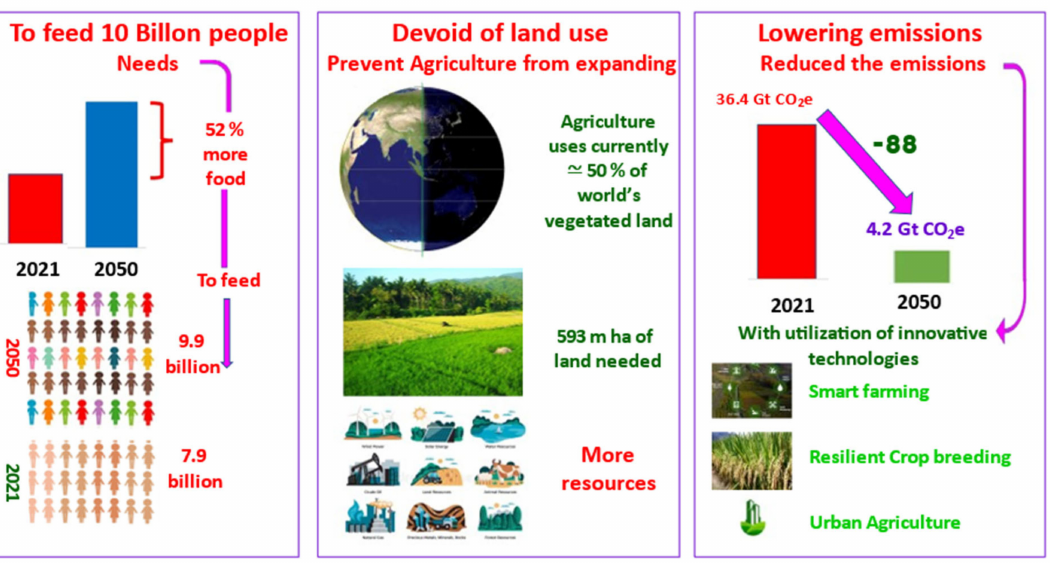
Figure 7. Challenges in sustainable future